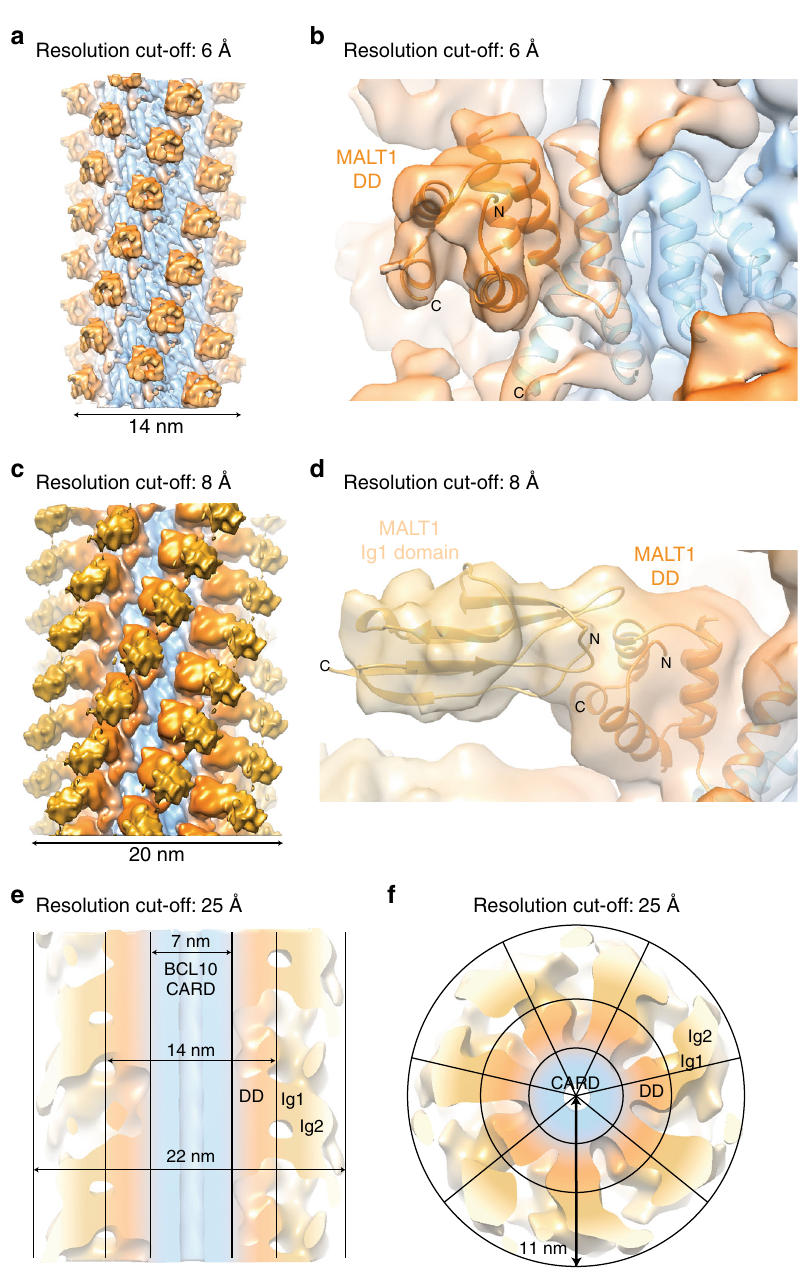
Fig. 6 Structural organisation of additional MALT1 domains in framework of the BCL10-MALT1 fi lament. a , b EM density map of the well-ordered inner core of the BCL10-MALT1 fi lament shown together with the atomic model of BCL10 (blue) and MALT1 DD (orange) as built in the 4.9 Å density map (map sharpening B-factor applied: − 200 Å 2 ). c , d Reconstructed density map fi ltered to 8 Å indicates the orientation of the MALT1 Ig1 domain shown as ribbon and colored yellow (B-factor applied: − 100 Å 2 ). e , f Paddle-wheel like architecture of the BCL10-MALT1 fi lament revealed by the EM-density fi ltered to 25 Å (B-factor applied: 0 Å 2